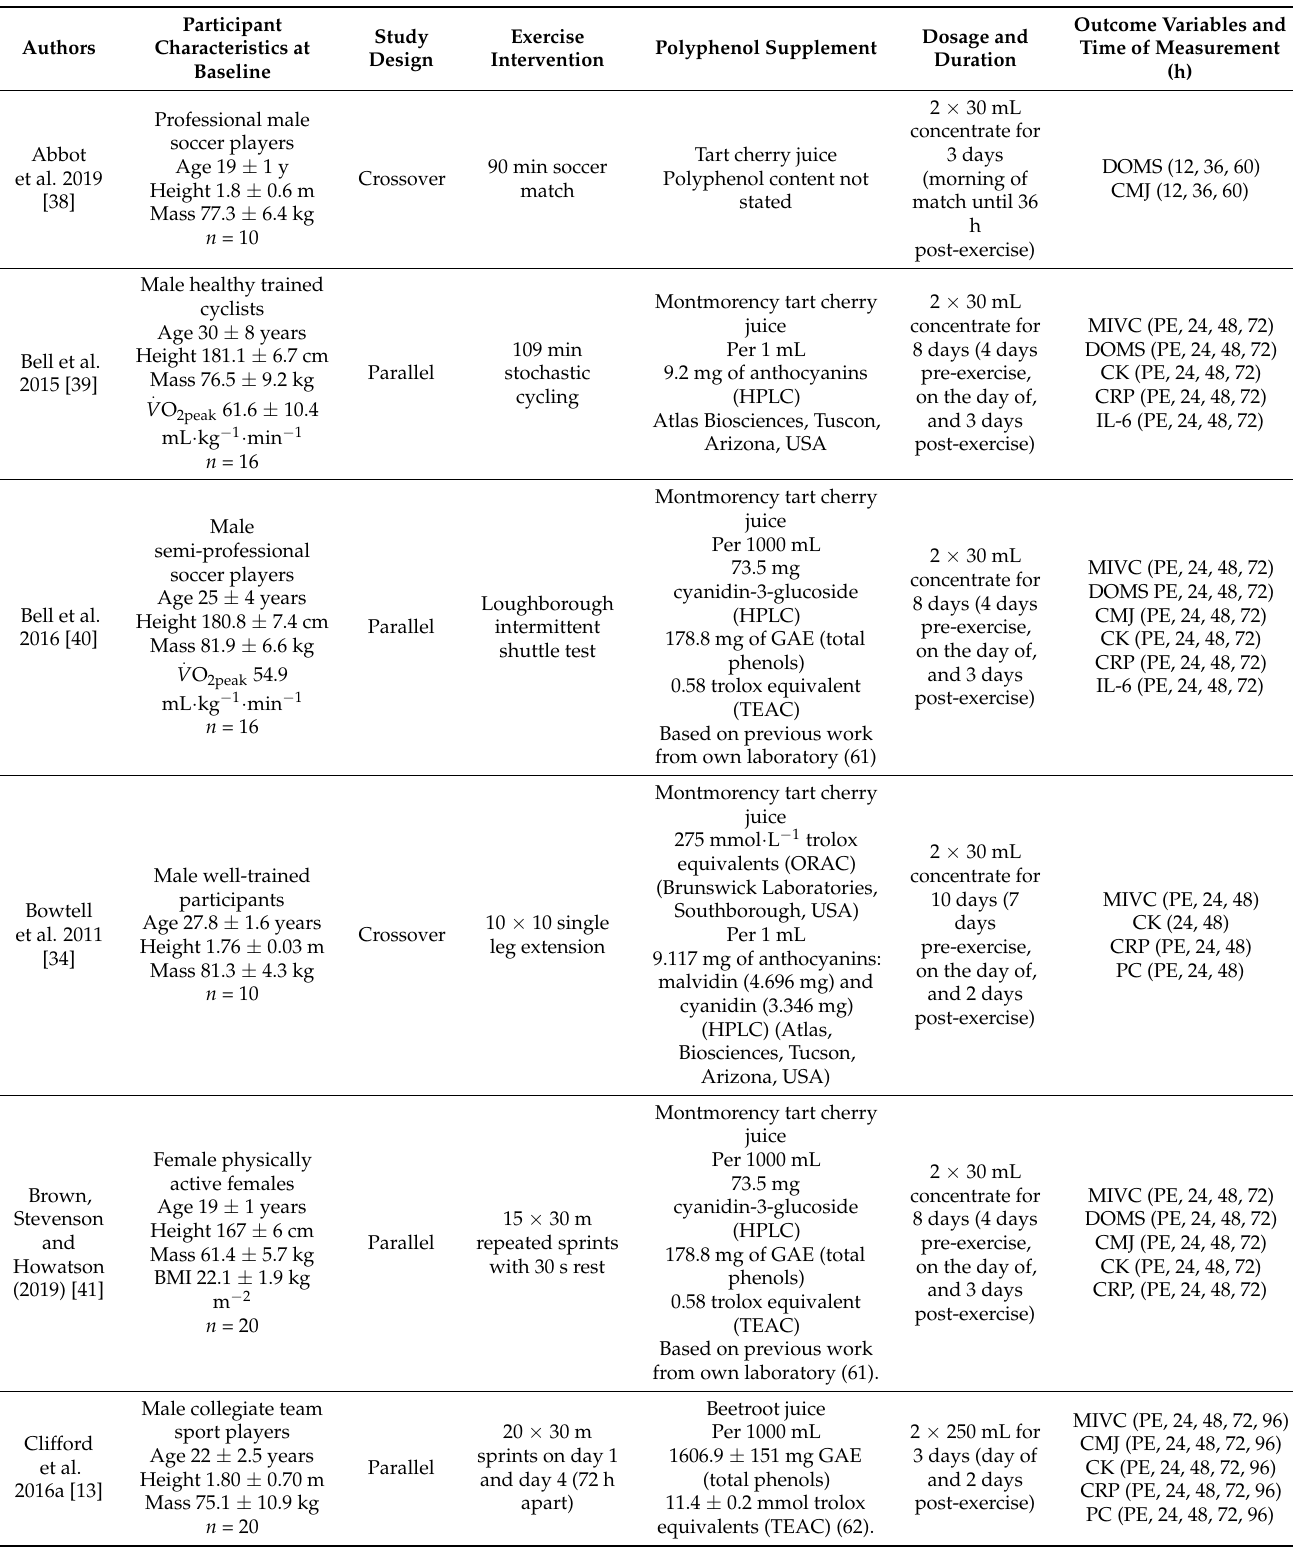
Table 1. Characteristics of the studies included in the systematic review and